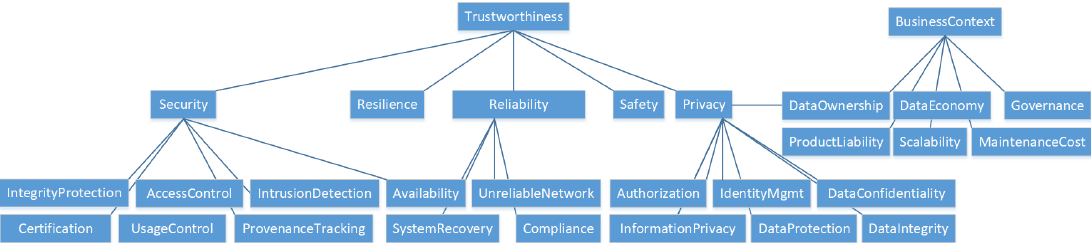
Figure 4. Selected extract of trust- and business-related concerns. Only the first two hierarchy levels are